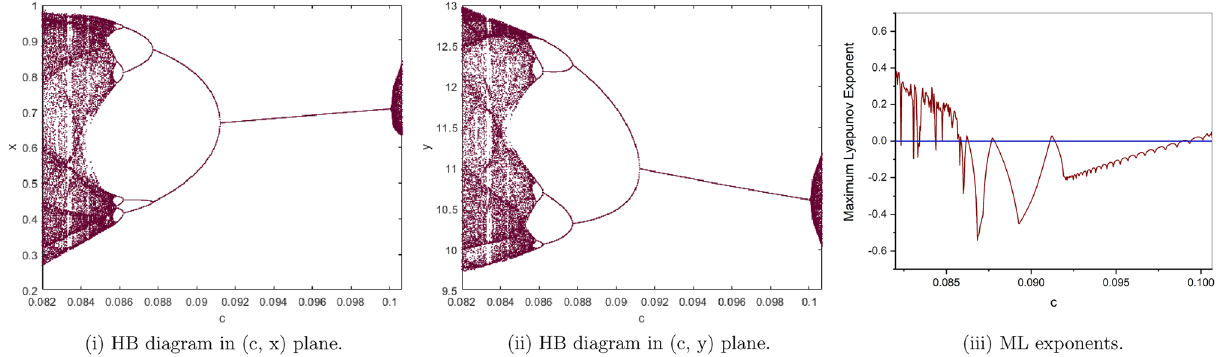
Figure 15. Bifurcation diagrams and ML exponents for the model (i) for values of a = 1.5, b = 0.5, e = 2, h = 3.75, c ϵ [0.082,